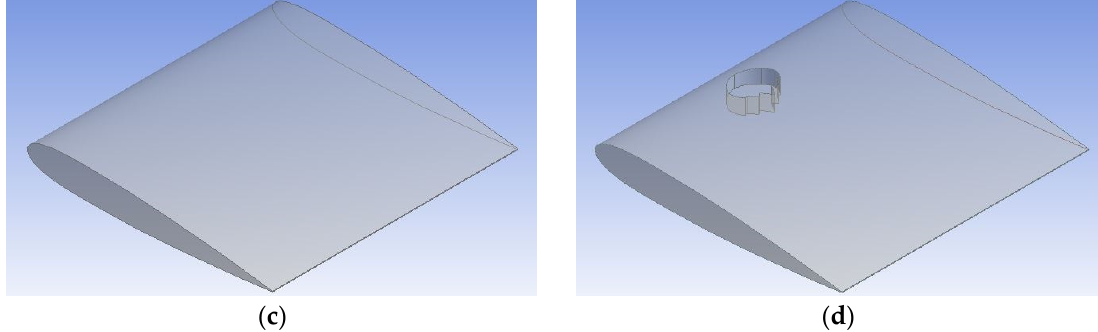
Figure 1. Aerofoil computational design. ( a ) Requiem shark skin’s SEM image. Adapted from [18]. ( b ) Raw riblet pattern. ( c ) NACA 0012 aerofoil. ( d ) 1RR HPBA.